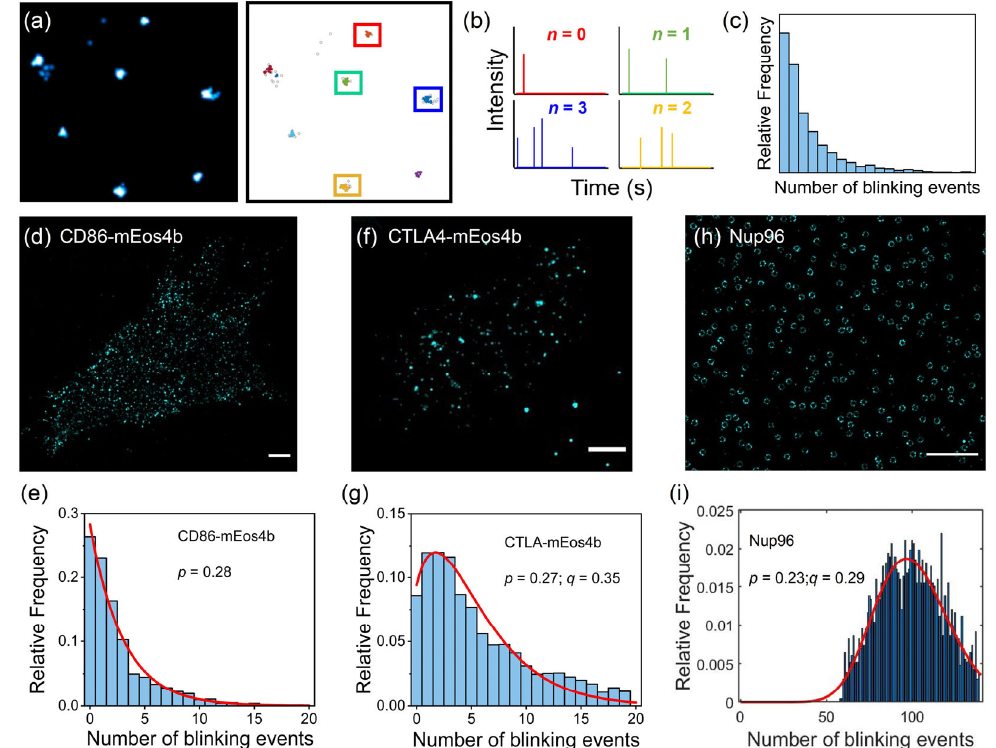
Figure 10. Applying FACAM in counting protein molecules. ( a – c ) The process of determining the number of blinking events in an intra-cluster. ( a ) A reconstructed super-resolution image of mEos4b and its clustering result using FACAM. ( b ) Schematic intensity time traces showing the number of blinking events ( n ) of single mEos4b molecules. The di ff erent color box contains the di ff erent clusters. ( c ) Relative frequency of the number of blinking events of mEos4b molecules. ( d , e ) A reconstructed super-resolution image of CD86-mEos4b and the corresponding distribution of the number of blinking events in the intra-cluster. R 2 : 0.98. The number of clusters is 1250. ( f , g ) A reconstructed super-resolution images of CTLA4-mEos4b and the corresponding distribution of the number of blinking events in the intra-cluster. R 2 : 0.95. The number of clusters is 3275. Clusters with irregular shapes and overlapping clusters were fi ltered out. ( h , i ) A reconstructed super-resolution image of Nup96 viewed as 32-mers and the corresponding distribution of the number of blinking events in the intra-cluster. R 2 : 0.93. The number of clusters is 2319. Clusters that are heavily vestigial and overlapping are fi ltered out. Scale bar: 2 µm ( b , d ), 1 µm ( f ).